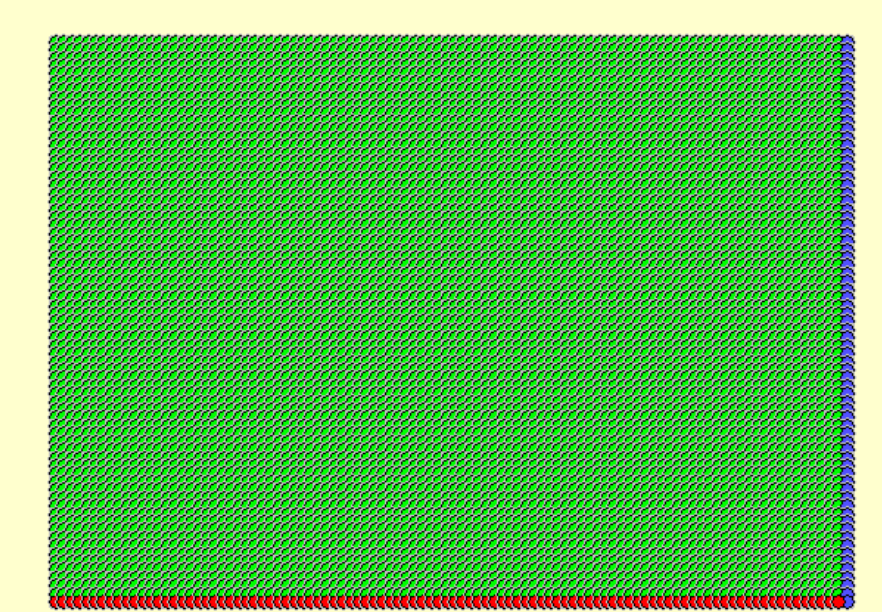
Figure 6. The full coverage map of the grids on the city’s DSM–DEM. The calculation process of the building’s frontal density area is shown in Figure